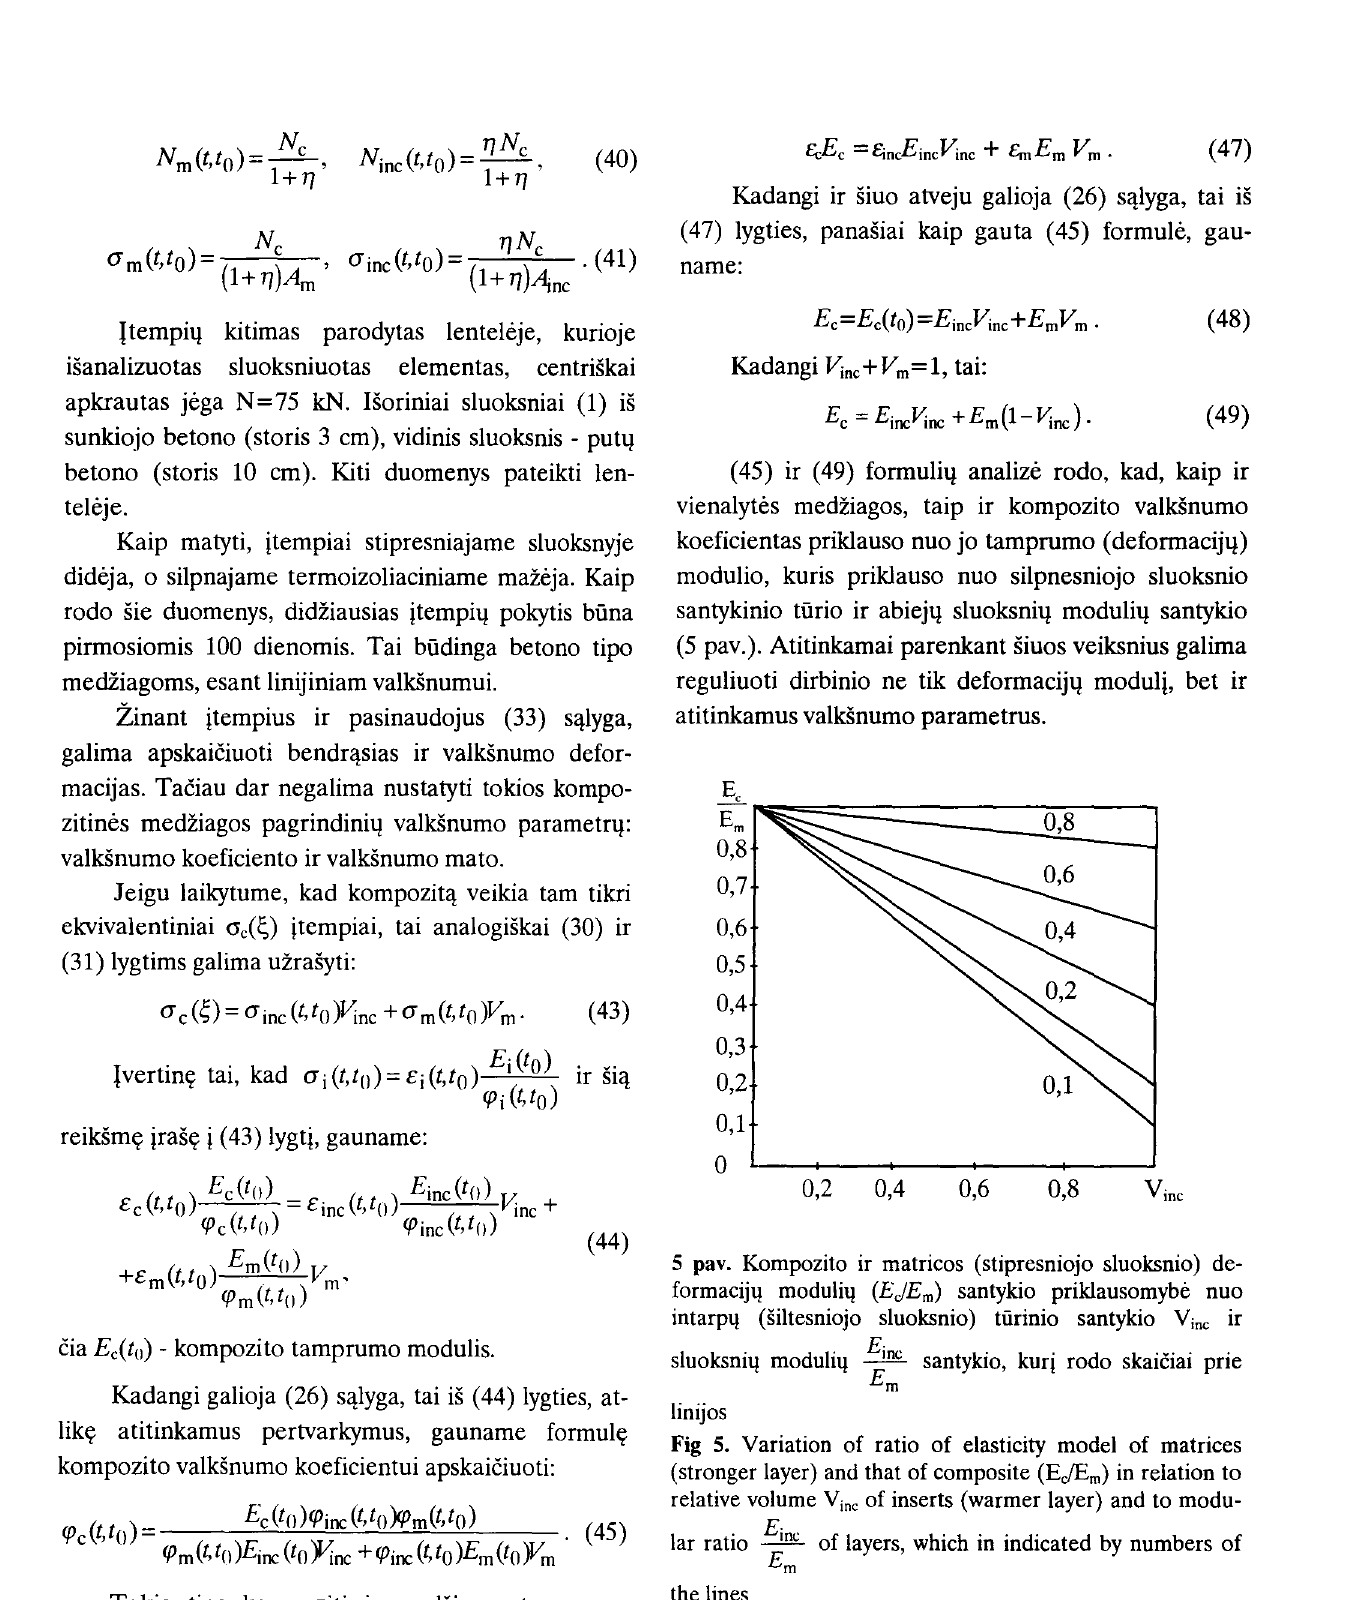
Fig 5. Variation of ratio of elasticity model of matrices (stronger layer) and that of composite (EJEm) in relation to relative volume Vine of inserts (warmer layer) and to modu- lar ratio Einc of layers, which in indicated by numbers of Em the